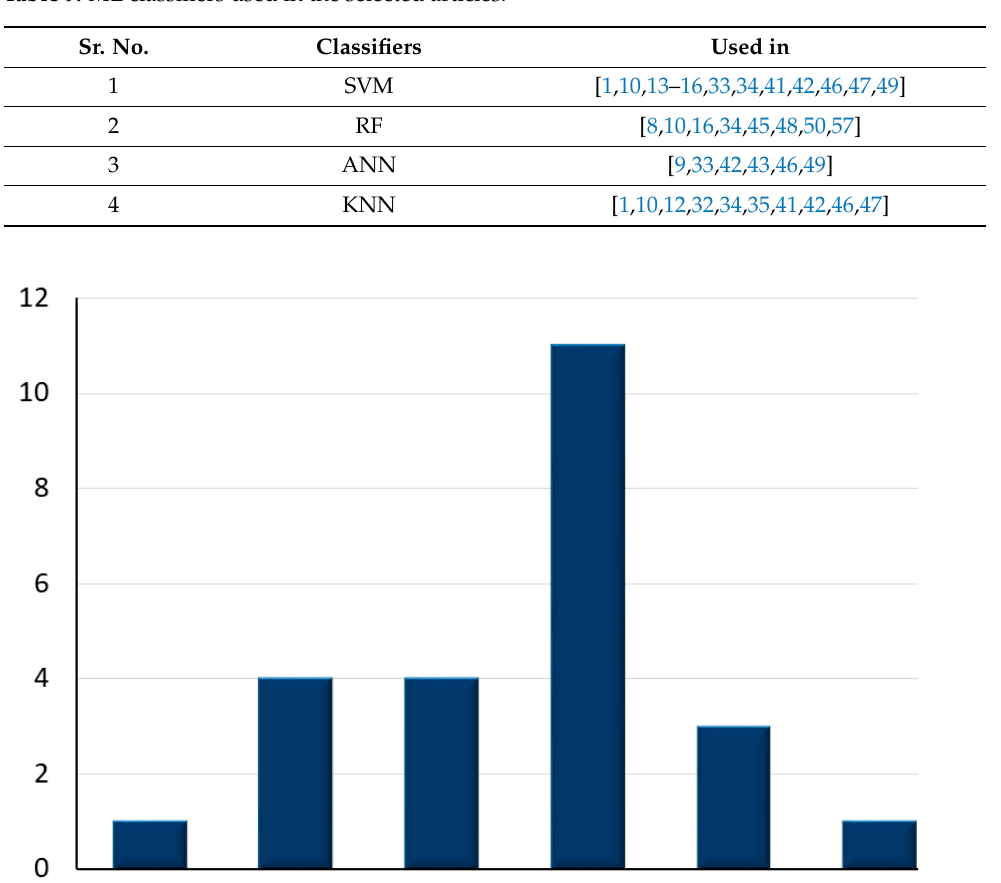
Table 9. ML classifiers used in the selected articles.